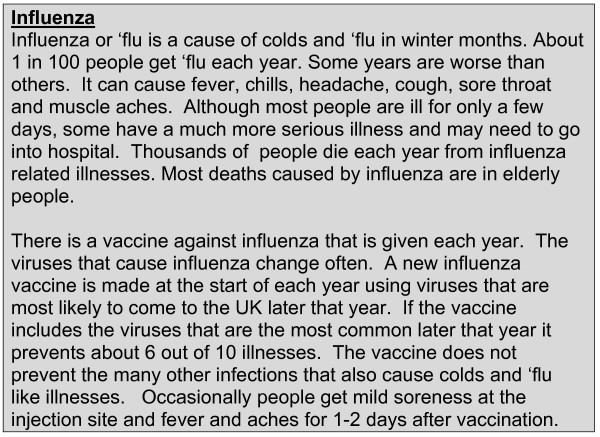
Patient information provided on influenza and influenza vaccination.